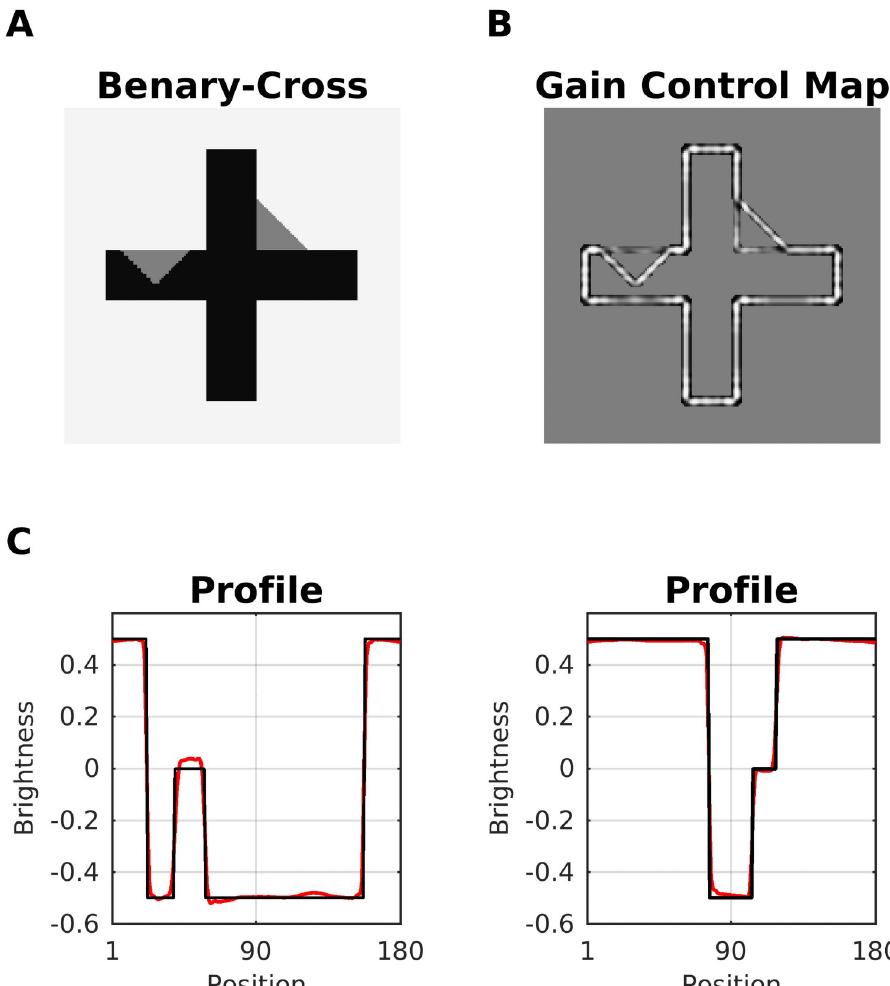
Fig 10. Prediction for Benary Cross illusion. (A) Benary Cross (input). Both triangles have the same intensity, but the triangle embedded in the cross is perceived as brighter. (B) In the gain control map, redundant edges (=aligned with the cross) of the triangle are weakened. (C) Profile plots of predicted brightness (red line) versus luminance (black line). The left profile plot shows the left